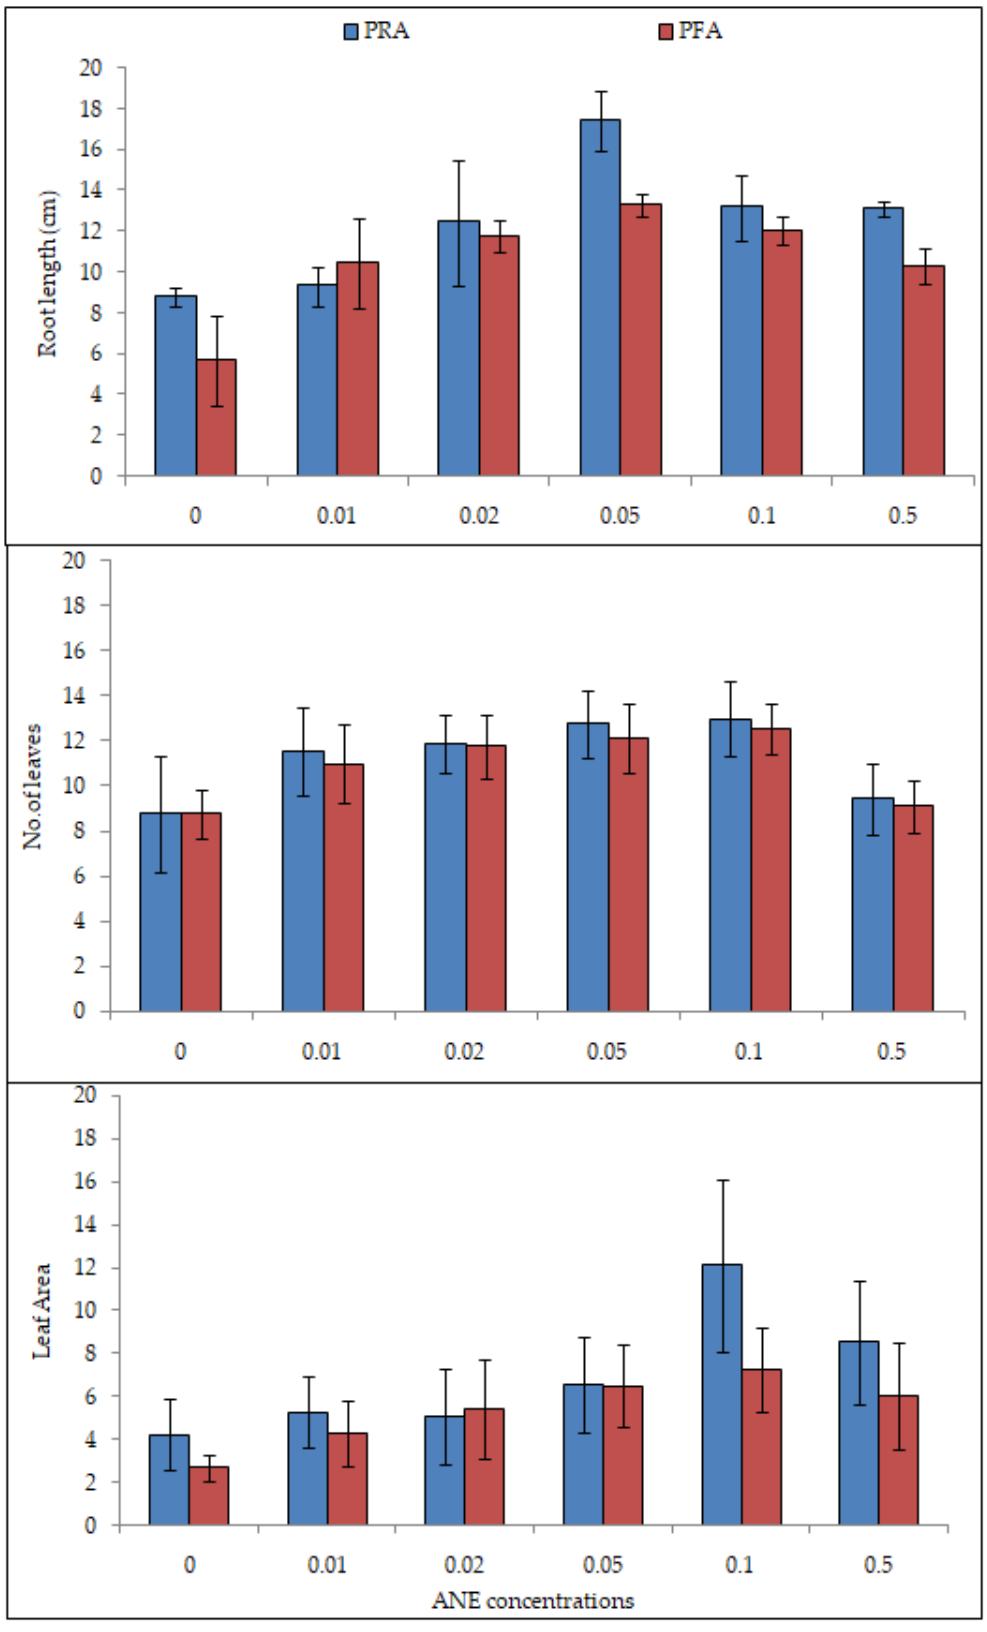
Figure 3. Efficacy of ANE treatment after pot foliar (PFA) and root application (PRA) on root growth, number of leaves, and leaf area on 30th day of growth of V. aconitifolia. Bar indicates mean ± SD (n = 3).